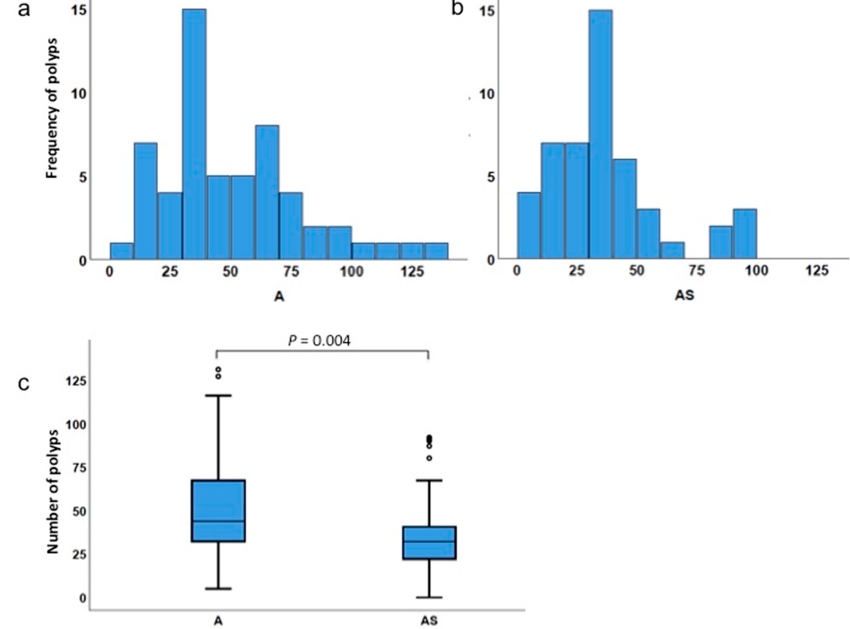
Figure 2. Polyp incidence in Apc Min /+ and ApcMin /+ ;Sf1 +/ − intestines. ( a , b ) Frequency distribution of number of polyps in Apc Min /+ (A) and ApcMin /+ ;Sf1 +/ − (AS) mice. ( c ) Box plot comparing total number of polyps in Apc Min /+ (A) and ApcMin /+ ;Sf1 +/ − (AS) mice. The box plots are a graphical representation of the five-number-summary for the number of polyps: the minimum value (the bottom whisker), first quartile (lowest line of the box), median or second quartile (line inside the box), third quartile (top line of the box), and maximum value (top whisker). Actual values are listed in Table